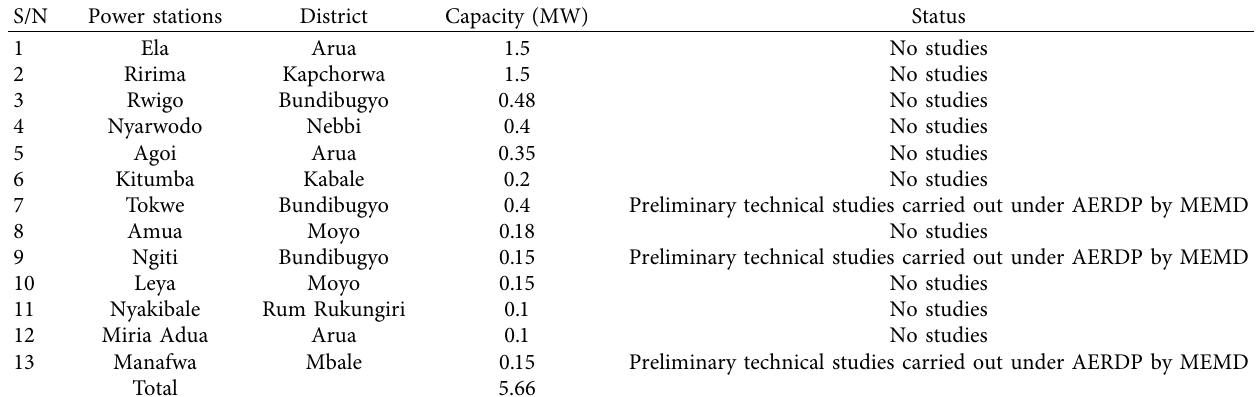
Table 8: Small hydropower plant available for development.